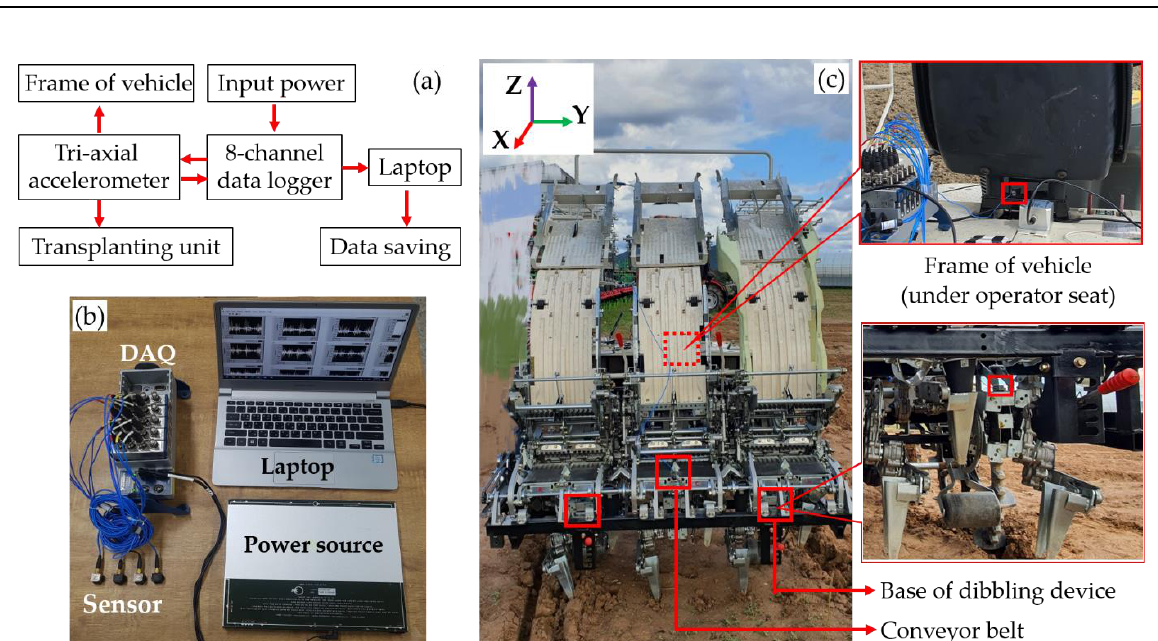
Figure 2. Block diagram of the ( a ) data acquisition system, ( b ) photo of the data acquisition unit, and ( c ) sensor placements.